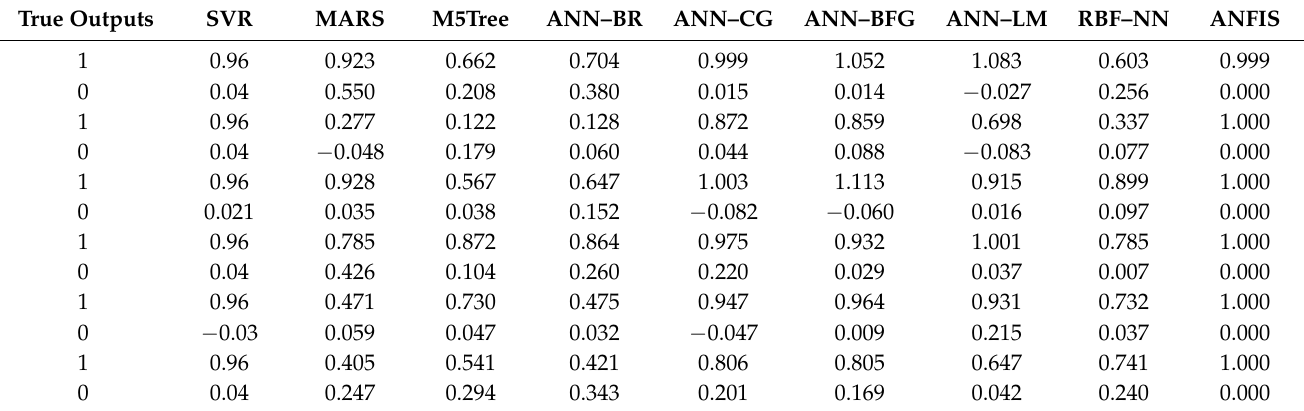
Table 10. The true data versus the predicted data of CVDs using ML approaches; see abbreviations in